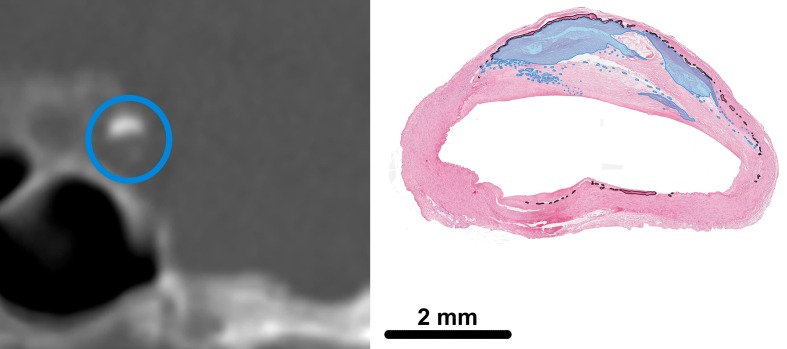
Intimal calcification in the intracranial internal carotid artery (iICA) on a coronal brain CT image (left) and on a histological slide (right).On CT a blue circle is placed around the iICA. In histology the intimal calcification area is light blue and the calcification area of the internal elastic lamina indicated by the black line.